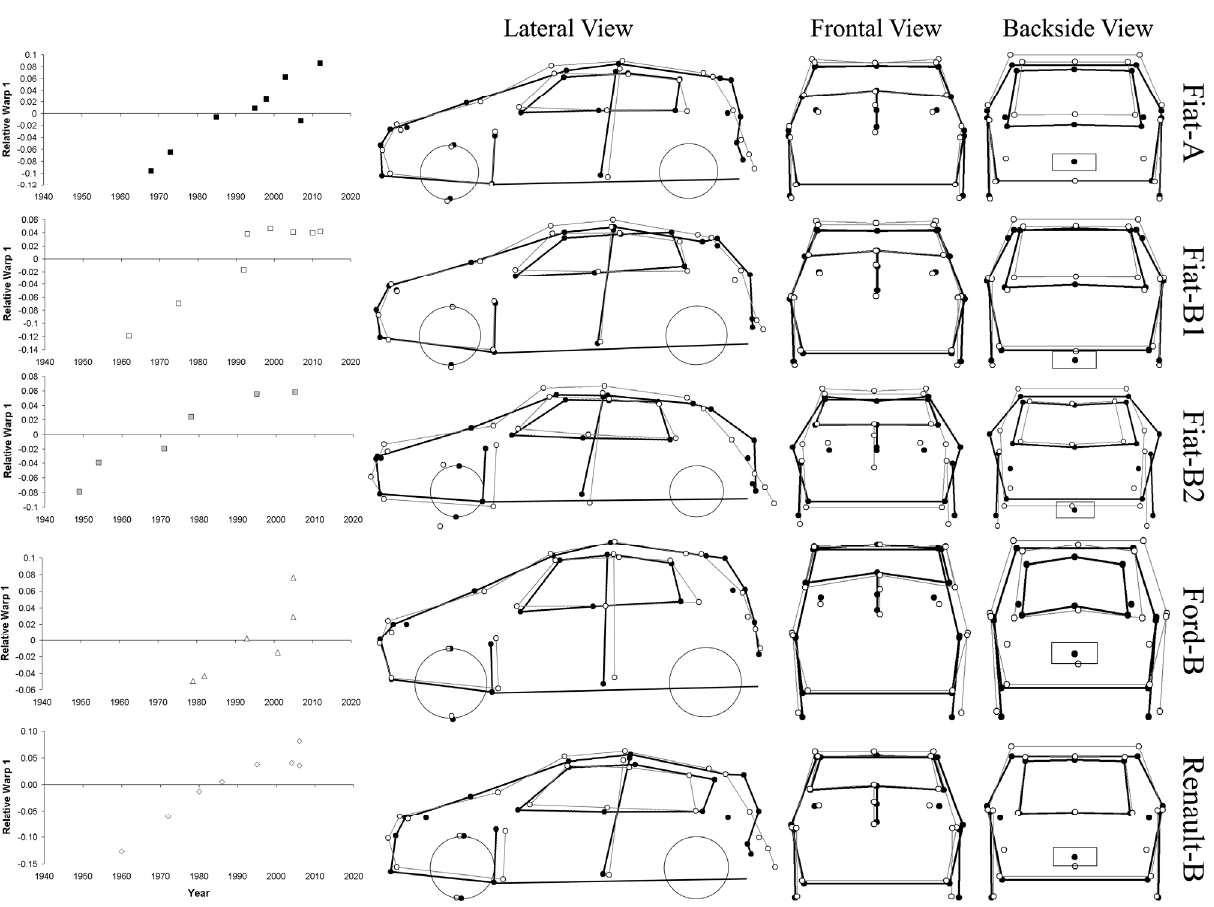
Figure 2. Regression analysis outputs for the first relative warp axis and the production year for each brand segment as a group, with sample size greater than five (left side of the figure). On the right side of the figure, the splines relative to the different views (lateral, front, and back) of the consensus configuration (thin grey line and white points) are